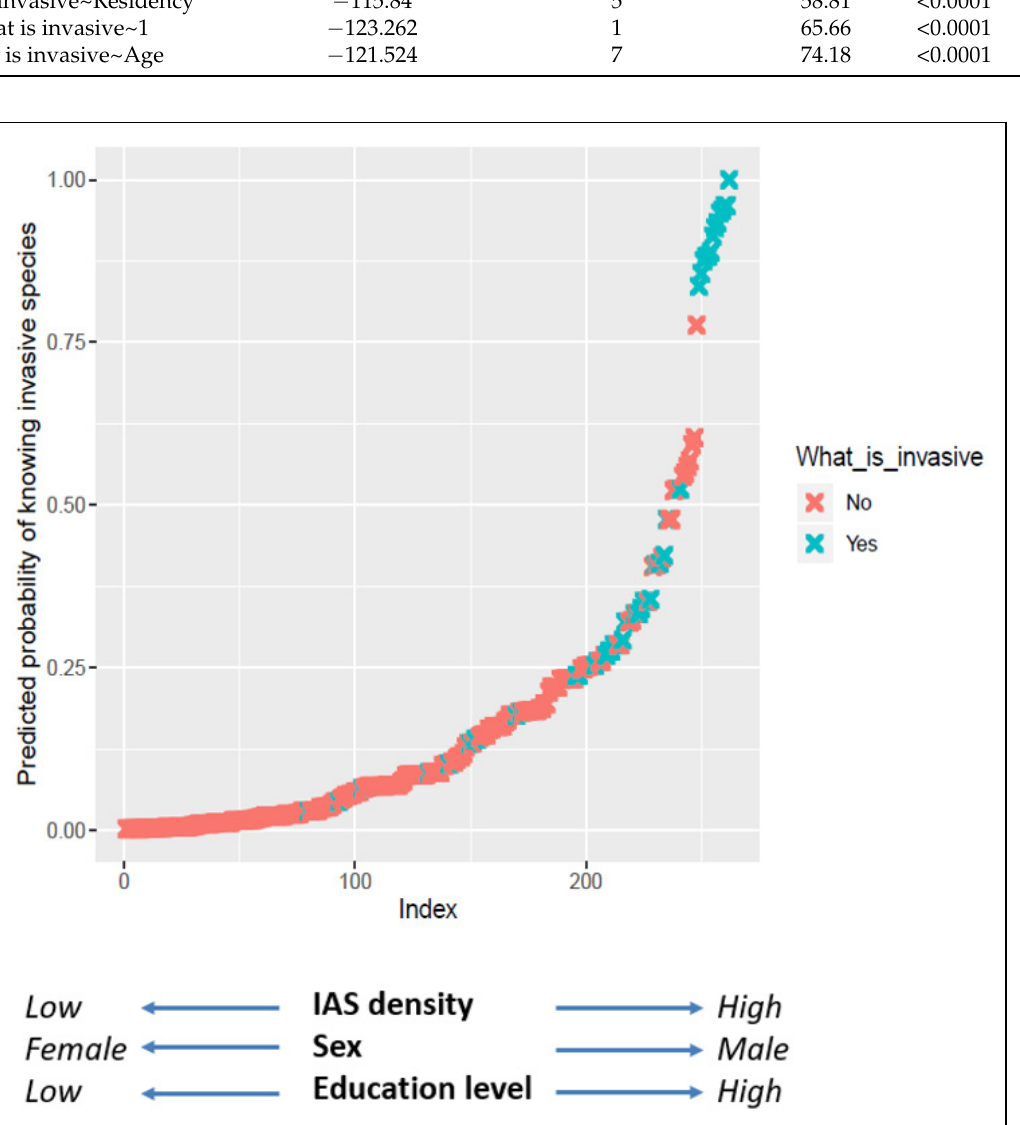
Figure 3. The relationship between awareness of IAS and alien plant density. The graph shows that awareness on IAS was linked to invasive plant density. The best candidate model selected had explanatory variables of higher education, higher alien density, and gender (men) to explain awareness of the term IAS by people. ‘Index’ represents the best model in Table 1.